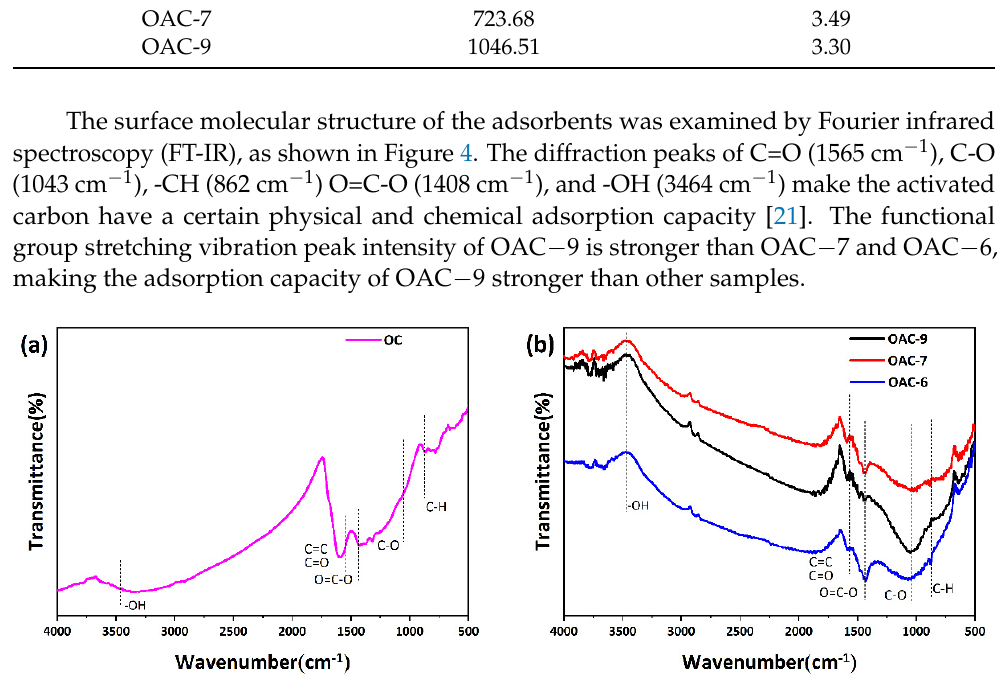
Figure 4. ( a ) FT-IR spectra of OC, and ( b ) FT-IR spectra of OAC − 6, OAC − 7, and OAC − 9. X-ray photoelectron spectroscopy (XPS) was used to characterize the elements con- tained in the adsorbents and the chemical states of the elements (Figure 5). Peaks of C and O were detected in all samples. These adsorbent materials all contain C and O elements.